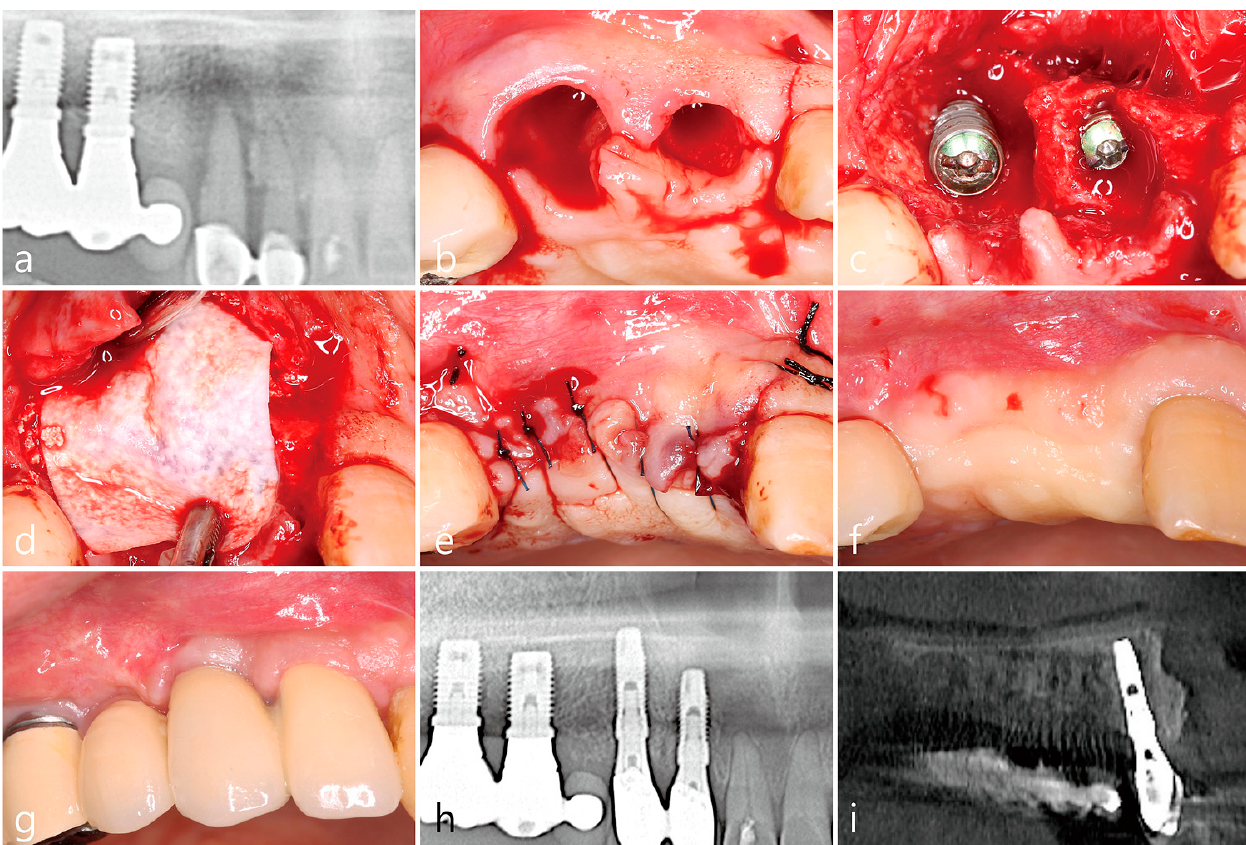
Figure 3. Clinical and radiological findings of case #3. ( a ) Pre-operative panoramic radiograph showing severe bone resorption and IGT around #13. ( b ) Mid-crestal and two vertical incisions after tooth extraction. ( c ) Implant #12 and #13 placement with peri-implant osseous defects. ( d ) Bone graft and resorbable collagen membrane placement over implants. ( e ) Flap closure with extended IGT. ( f ) Post-operative photograph showing healing with no flap exposure. ( g ) Final prosthesis #12 and #13. ( h ) Panoramic radiograph taken 35 months after prosthesis delivery. ( i ) Cross-sectional image of CBCT taken 35 months after prosthesis delivery with sufficient bone regenerated around the